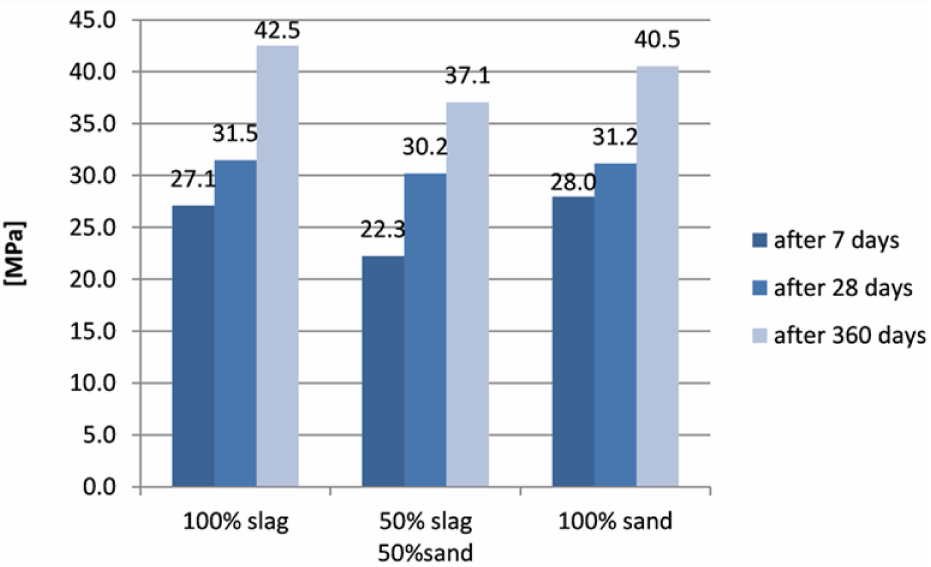
Figure 6. Compressive strength of samples without